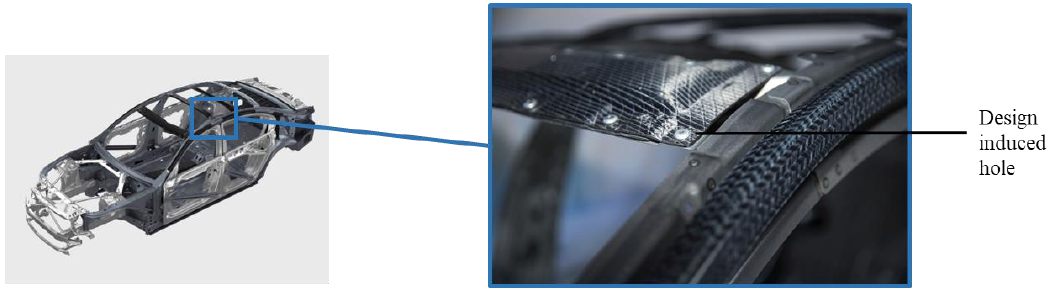
Figure 1. Fiber reinforced polymer (FRP) laminates with design-based holes for joining with steel in the new BMW 7 series (source: BMW, Munich, Germany).